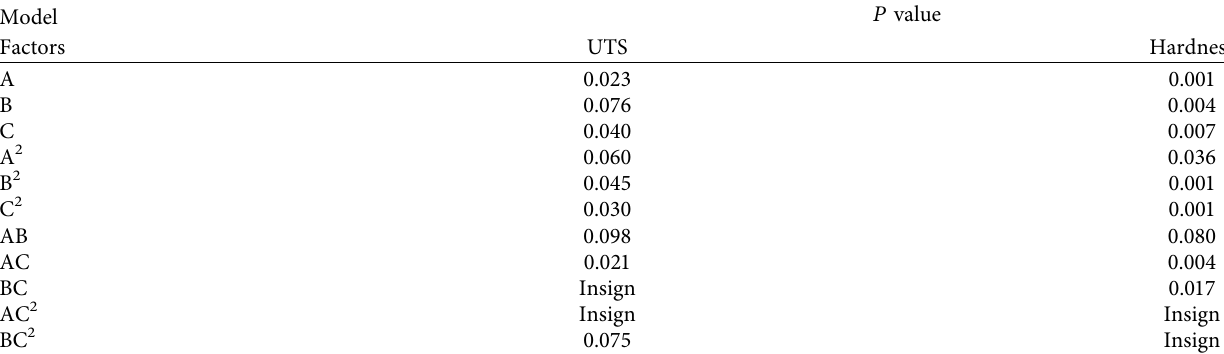
Table 4: Major factors and corresponding P values for the process of FSW.